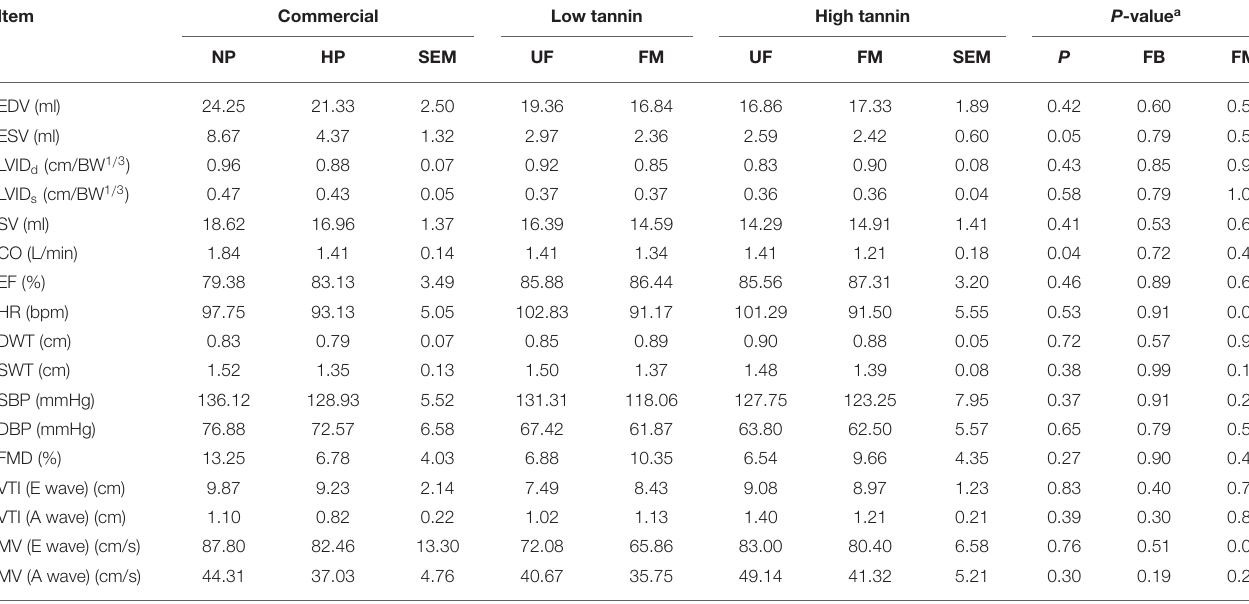
* Eight mixed-gender, neutered beagles were fed the NP or HP diets during the first and sixth weeks, respectively. From weeks 2 to 5, using a randomized, crossover, 2 × 2 Latin square design, 4 diets differing in fava bean variety and fermentation were compared as follows: unfermented (UF) high tannin, fermented (FM) high tannin, UF low tannin, and FM low tannin. Values expressed as means (n = 8). SEM, pooled standard error of the mean; EDV, left ventricular end-diastolic volume; ESV, left ventricular end-systolic volume; LVID d , left ventricular end diastolic diameter; LVID s , left ventricular end systolic diameter; SV, stroke volume; HR, heart rate; CO, cardiac output; EF, ejection fraction; DWT, left ventricle diastolic wall thickness;